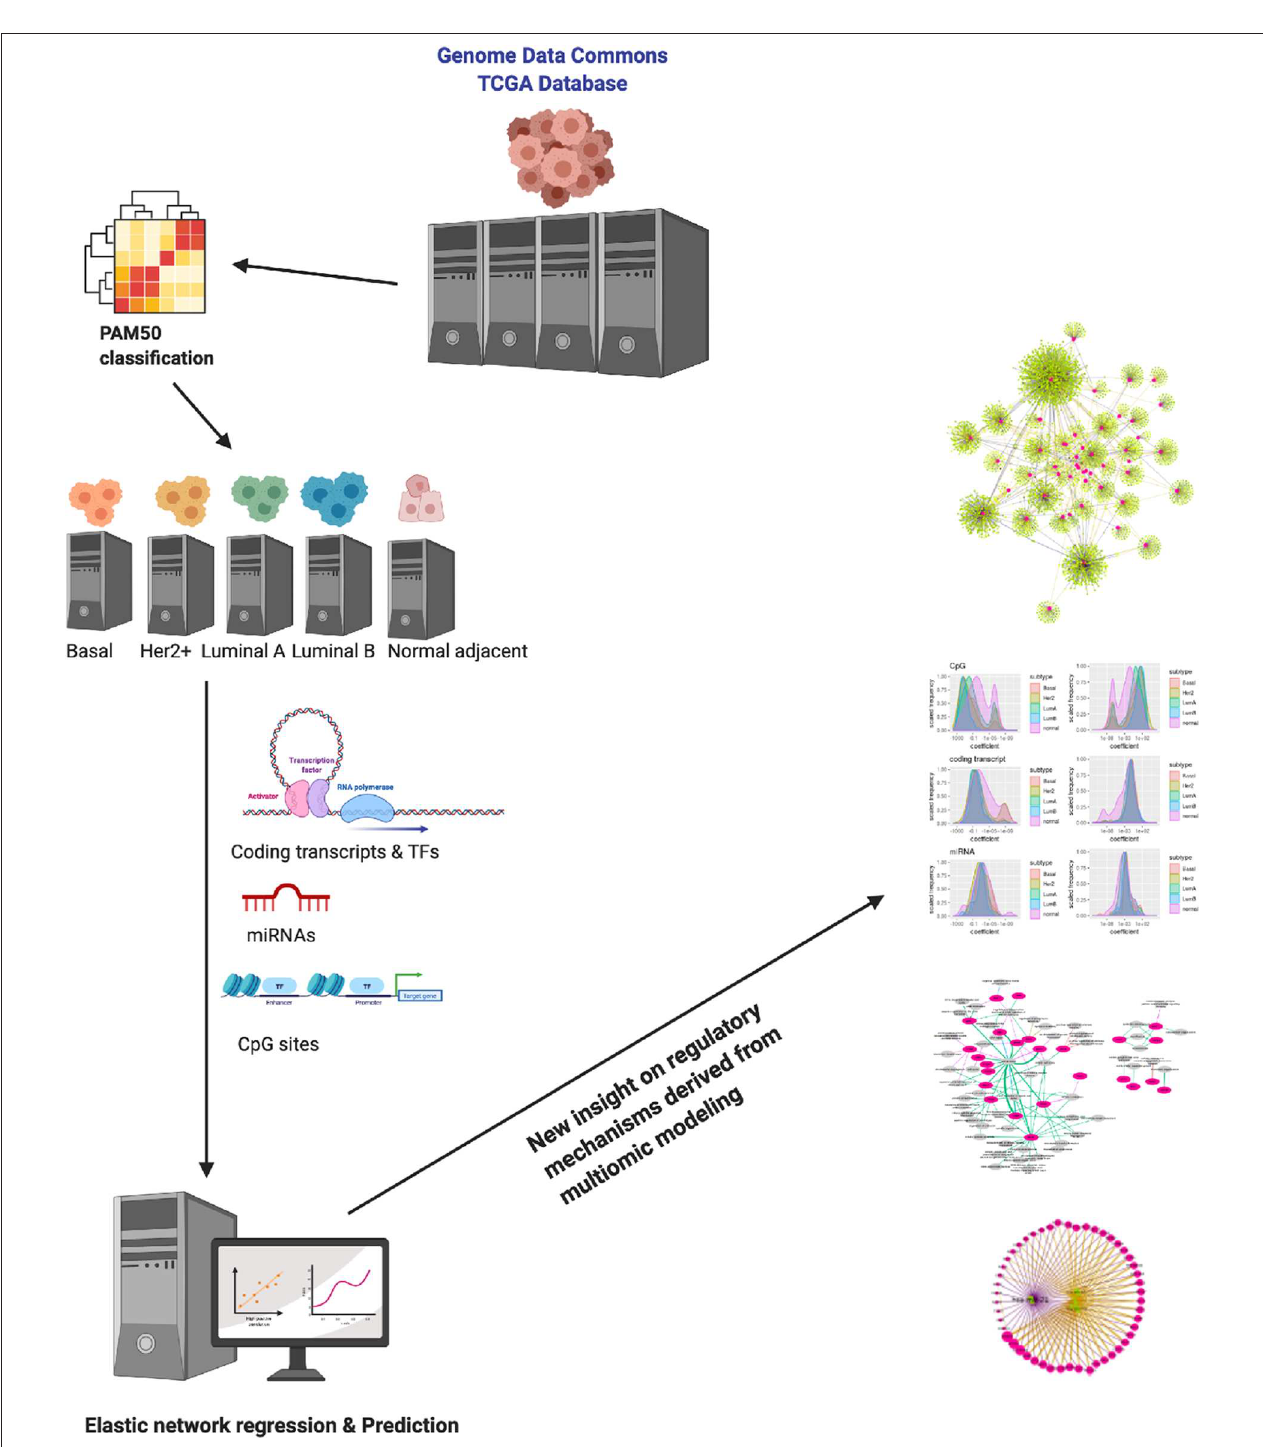
FIGURE 1 | Schematic depiction of this work. By analyzing multiomic data from the TCGA/Genome Data Commons collaboration for the different breast cancer molecular subtypes and healthy adjacent breast tissue via a generalized elastic network modeling, we have been able to derive some insight on the way the PAM50 genes are regulated (as predicted by the model). Results may shine some new light on the way PAM50 genes are able to capture intrinsic features of these phenotypes.